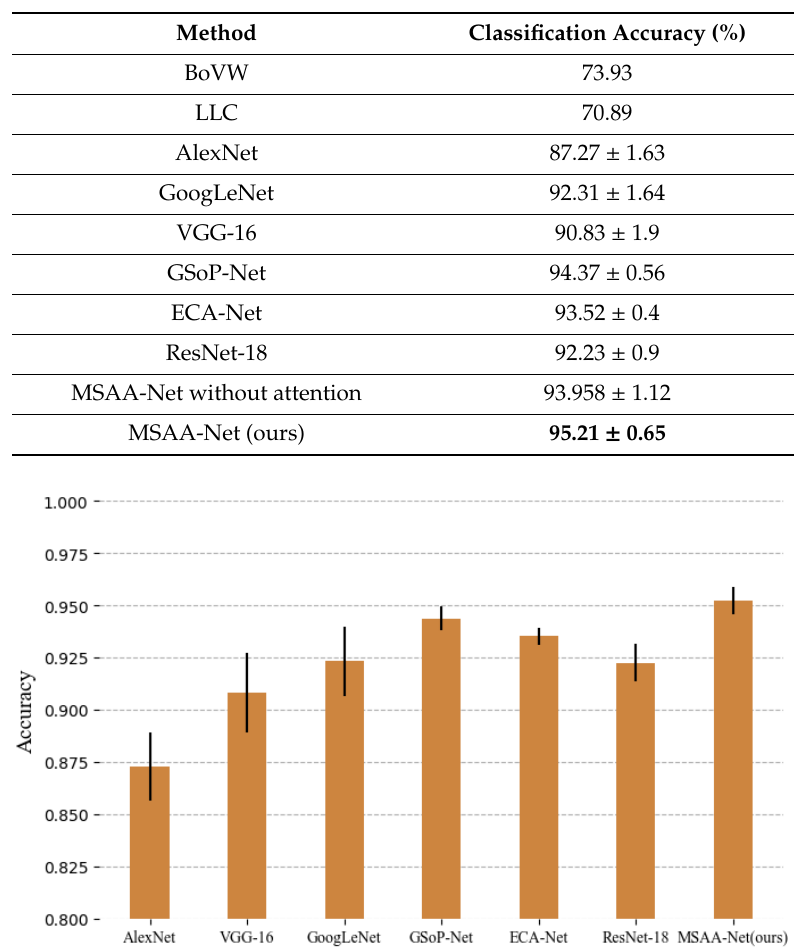
Table 3. Comparison between the previously reported accuracies for the Google dataset of SIRI-WHU, with 80% training samples selected.